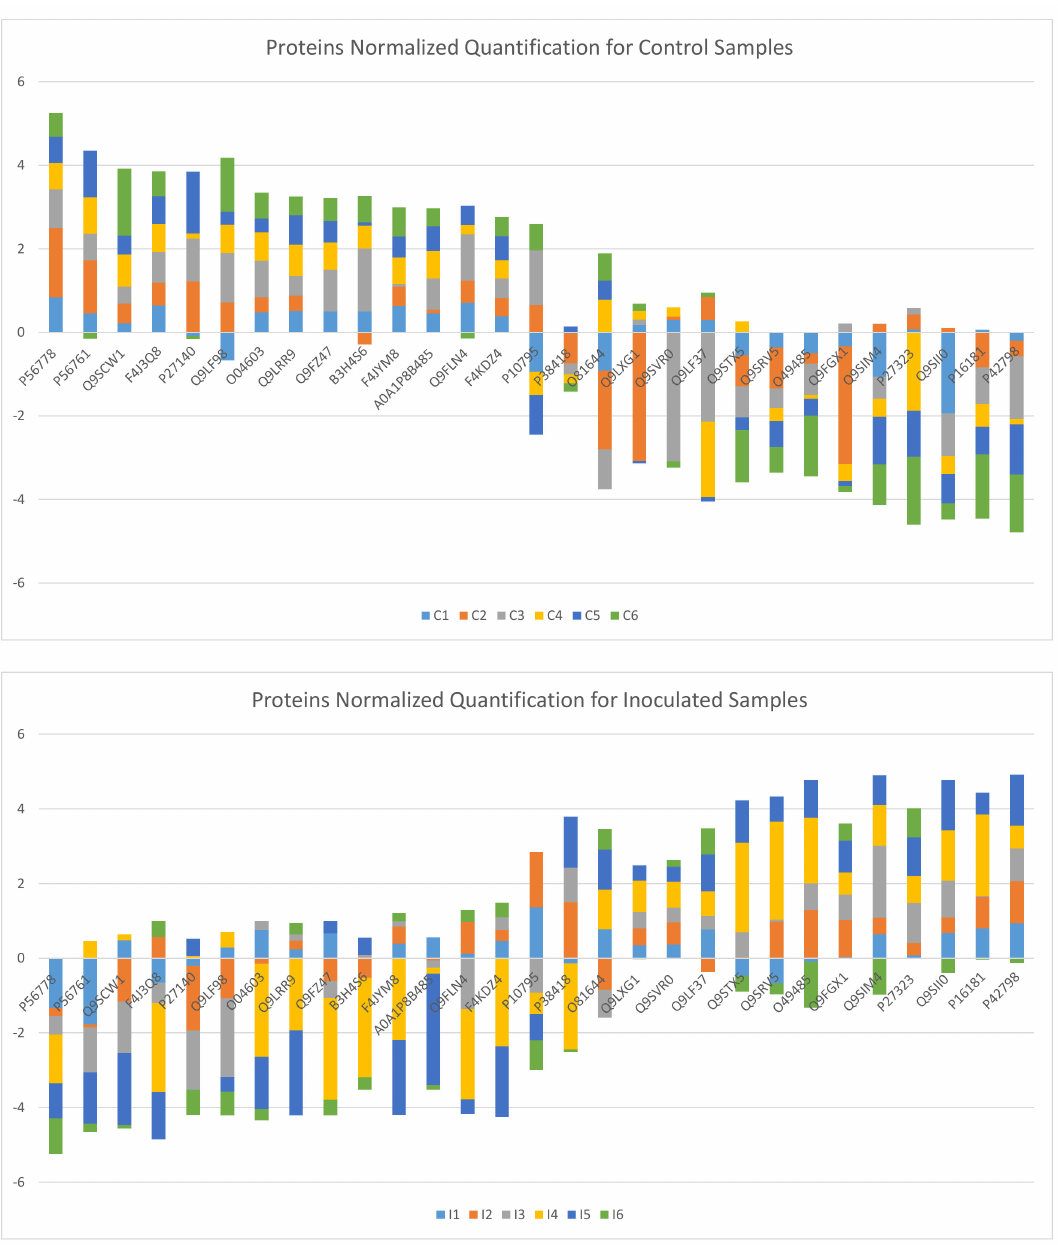
Figure 5. Stacked columns for the normalized quantification level of the optimal protein set for control samples ( up ) and inoculated samples ( down